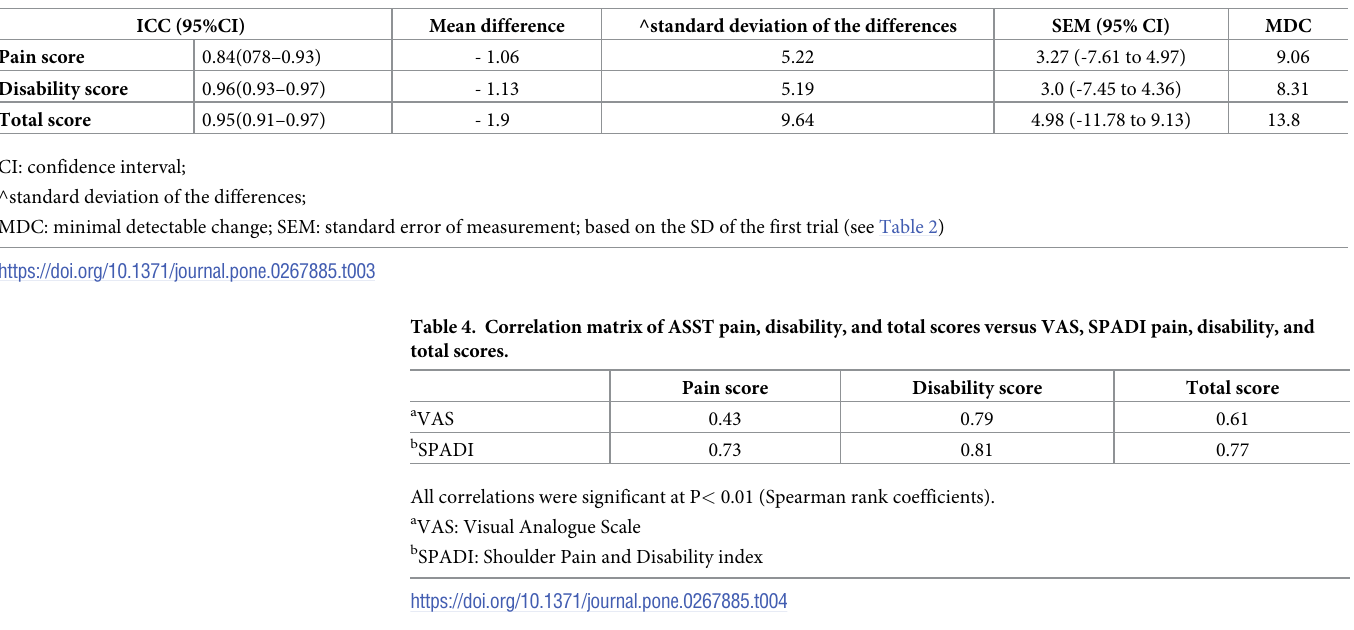
Table 3. Test-retest reliability and agreement measures of the Arabic shoulder simple test data.